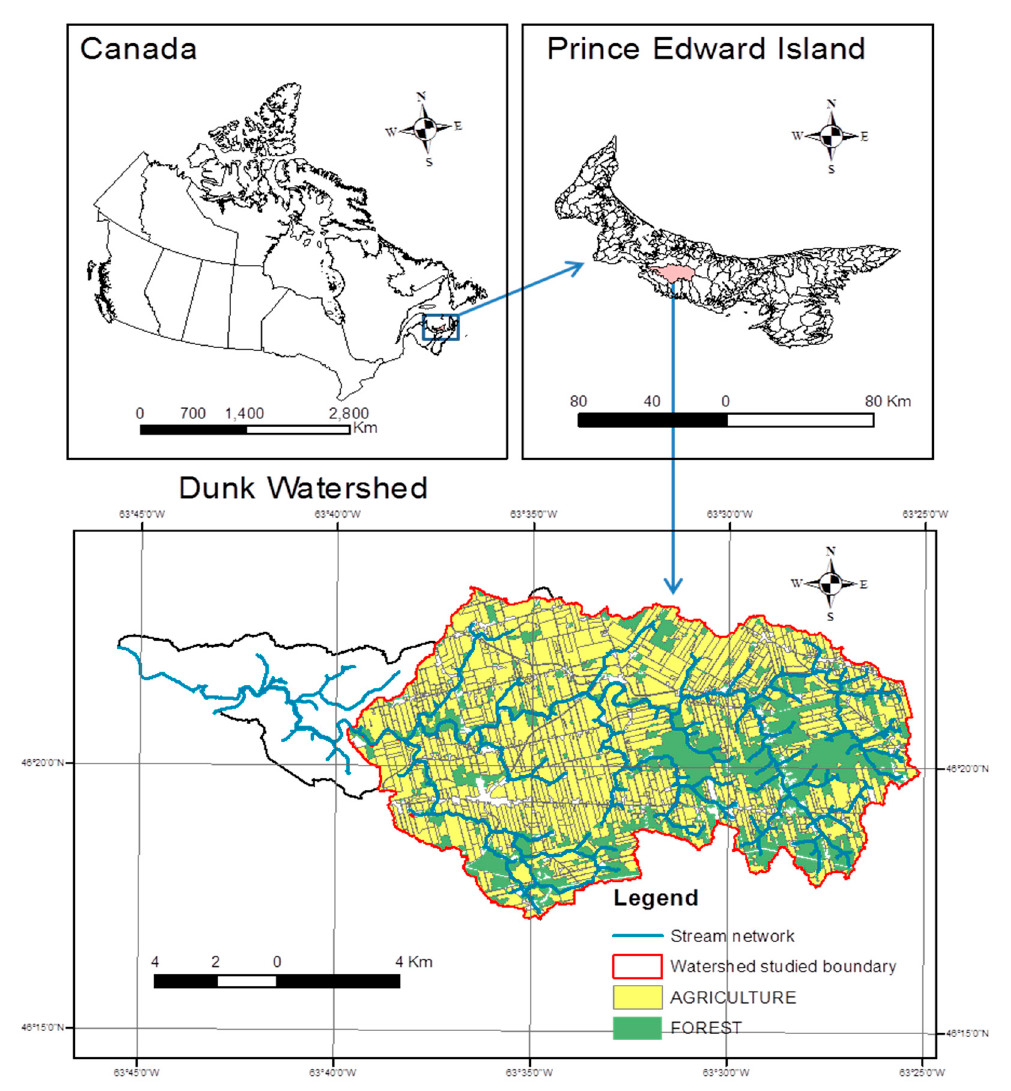
Figure 1. Dunk River Watershed location.